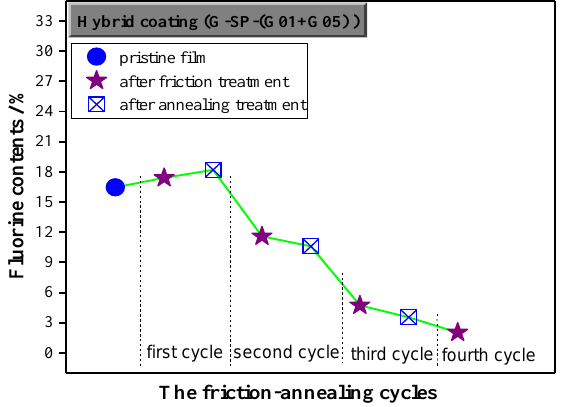
Figure 9. Change in fluorine fraction content at the surface for film with 2 wt.% G-SP-(G01+G05) during the abrasion–annealing cycle.